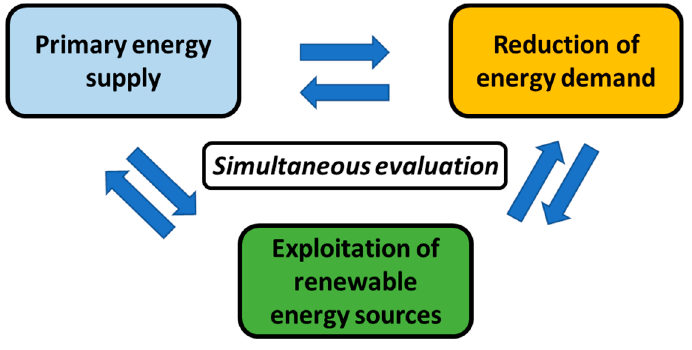
Figure 1. Integrated optimization.